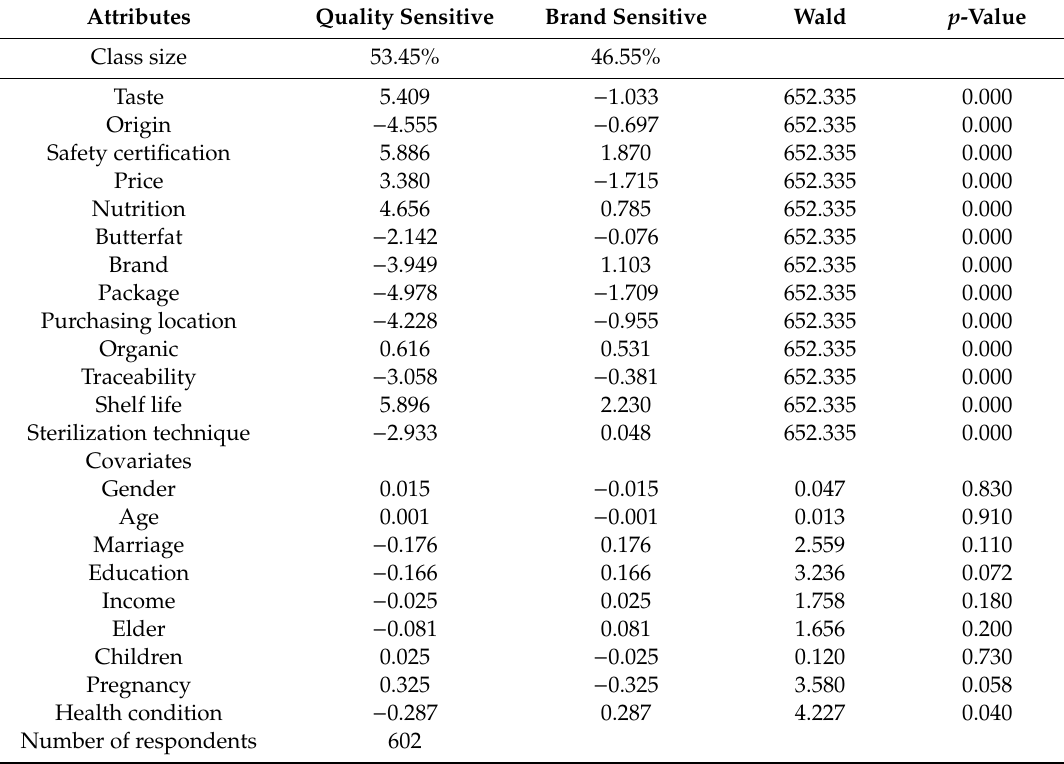
Table 7. Preference heterogeneities in less developed